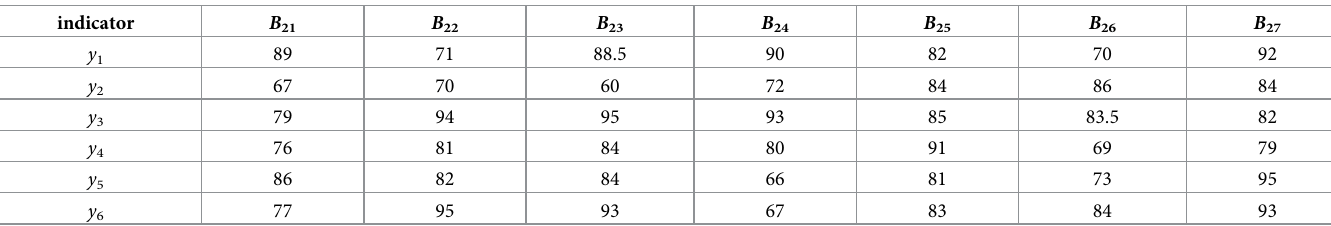
Table 3. Initial expert scoring data.